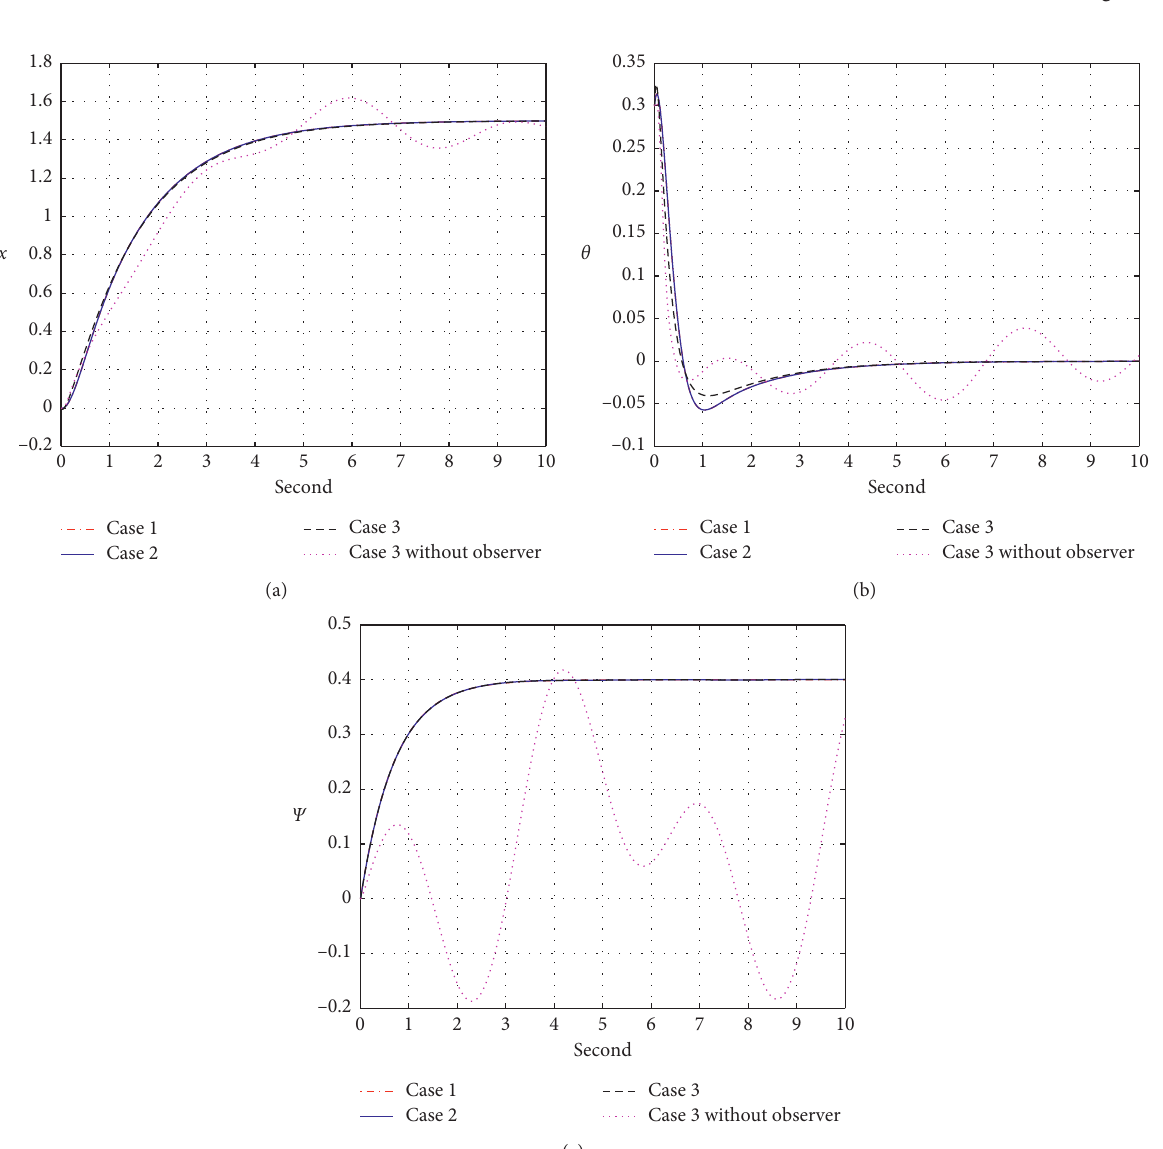
Figure 4: Position, pitch, and yaw angles of TWIR. (a) Position, (b) tilt angle, and (c) heading angle of the